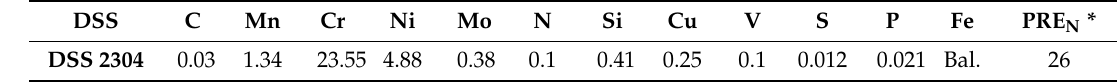
Table 1. Chemical composition (wt%) of DSS